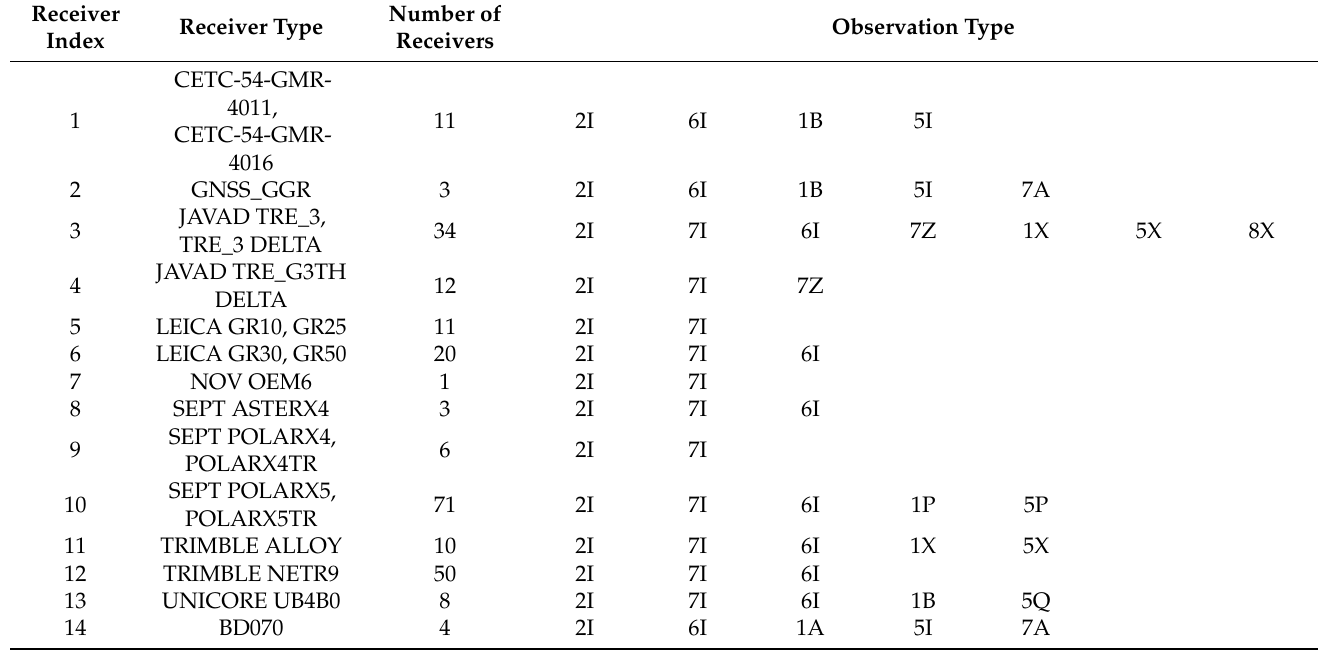
Table 3. Receiver and observation types based on RINEX observation